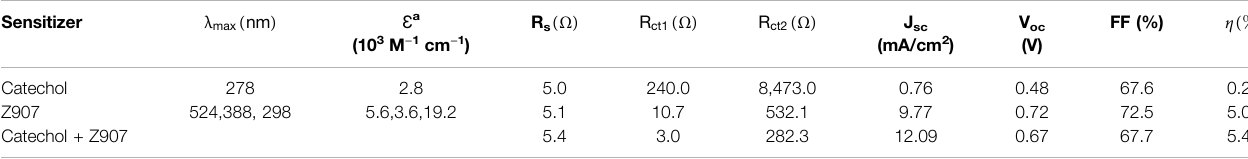
TABLE 1 | Photovoltaic, optical, and electrochemical responses of representative devices for the sensitizers in organic solvent – based electrolyte.